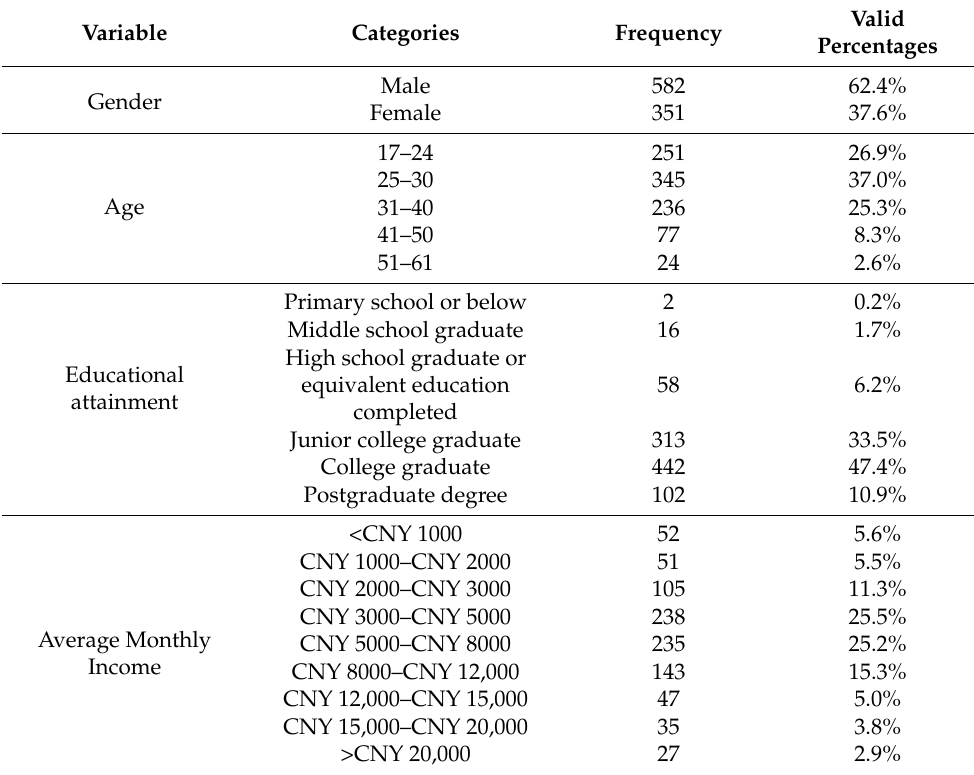
Table 1. Sociodemographic statistics for the sample in our study (N =